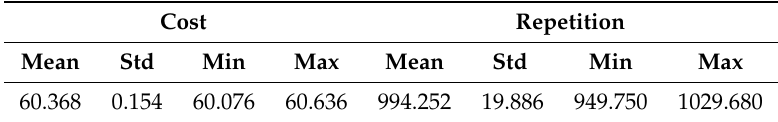
Table 4. Statistics for the cost and level of repetition achieved by ILS-MOEA/D, considering menu plans for n = 60 days, after ten hours of